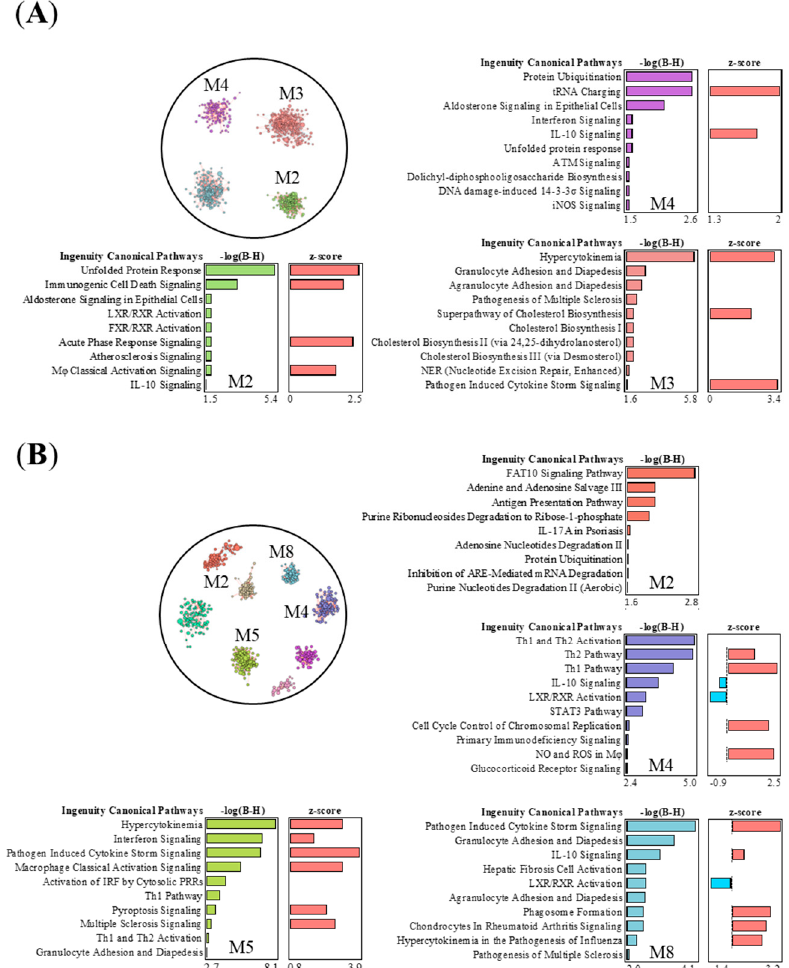
Figure 5. The nZnO- and nAg-treated mouse lung tissues have specific or shared response interaction modules and corresponding canonical pathways. Pathways of the negative logarithmic of the p -value calculated by the right-tailed Benjamini-Hochberg (B-H) larger than 1.5 are shown, and module color is matched with associated -log(B-H)-bars. ( A ) There are four modules in the top 700 DEGs of 50 µ g nZnO exposure group after 1 day, and three modules yielded the canonical pathways. ( B ) There are eight modules in the top 700 DEGs of 50 μ g nAg exposure group after 7 days, and four modules yielded the canonical pathways. The top 700 DEGs were selected for nZnO and nAg groups for INfORM to analyze network response modules, and then the canonical pathways analysis was completed by IPA.